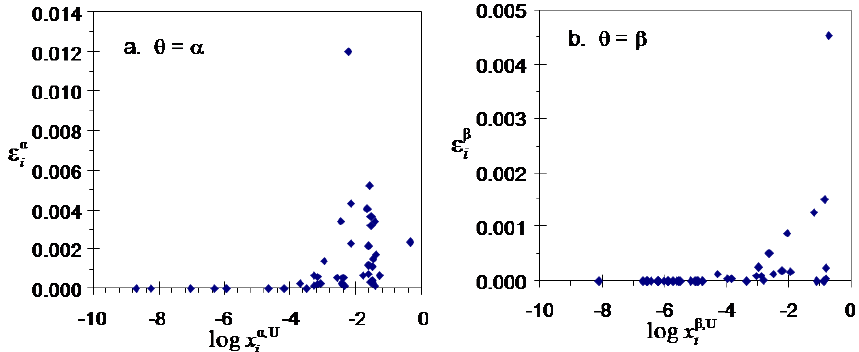
Fig. 4. Unsigned difference between the values of F θ vs. log x θ, U (U=UNIFAC) for θ = α and for θ = β in the performance evaluation (PE) case. i